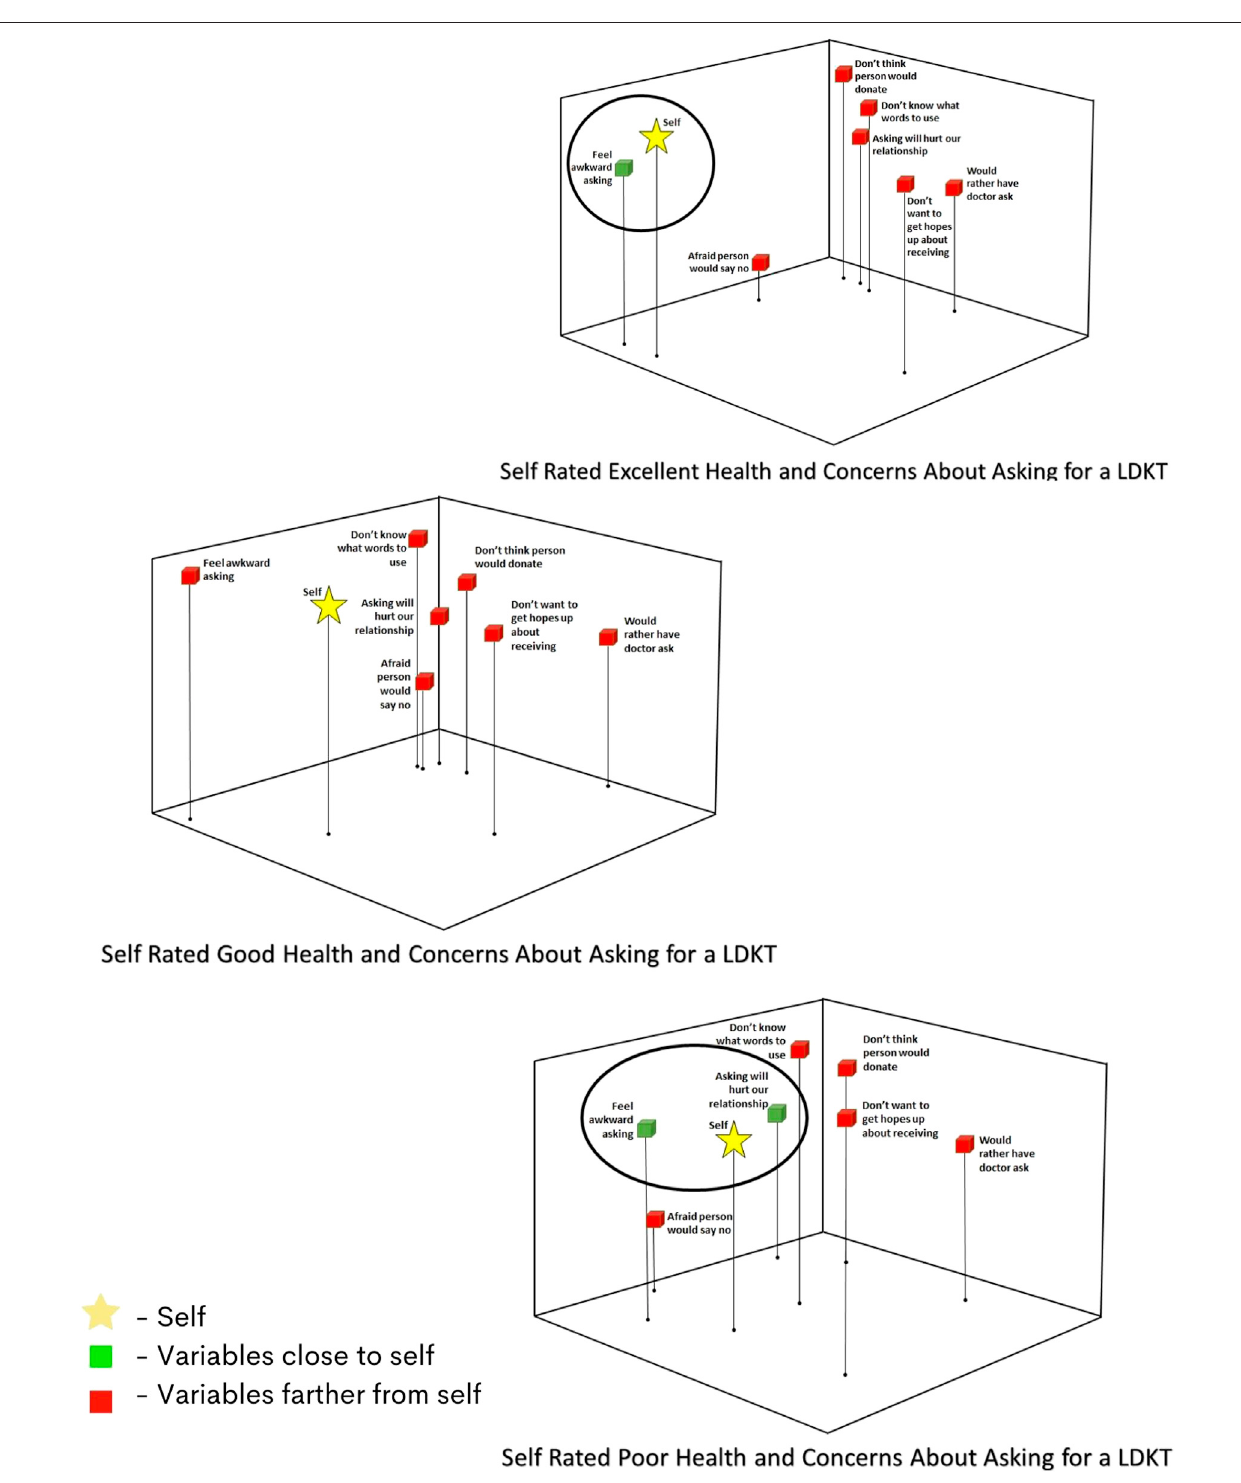
FIGURE 1 | Perceptual maps for concerns about asking for LDKT by self-reported health status.